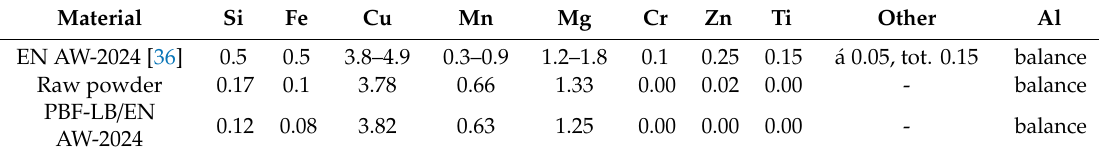
Table 2. Chemical composition of raw material, powder and PBF-LB/EN AW-2024 specimen.